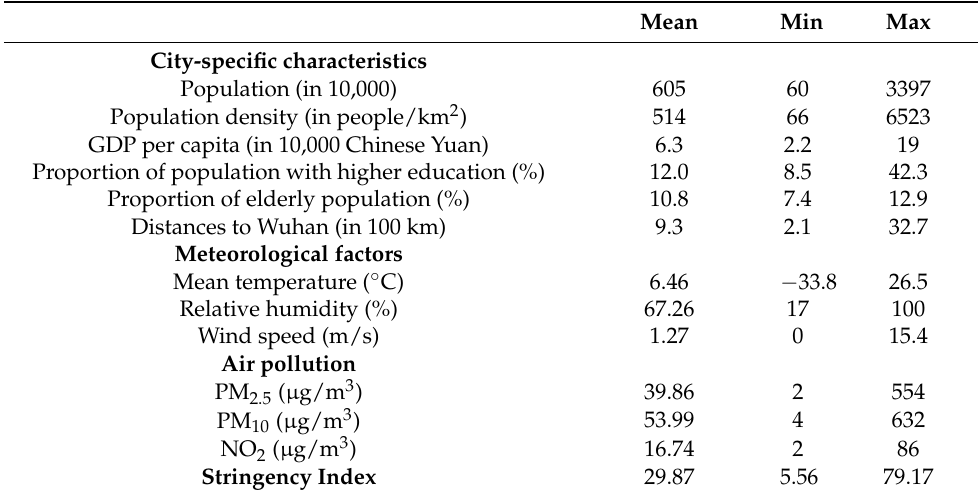
Table 2. Descriptive statistics of city-specific characteristics, air pollution, meteorological factors, and stringency index in